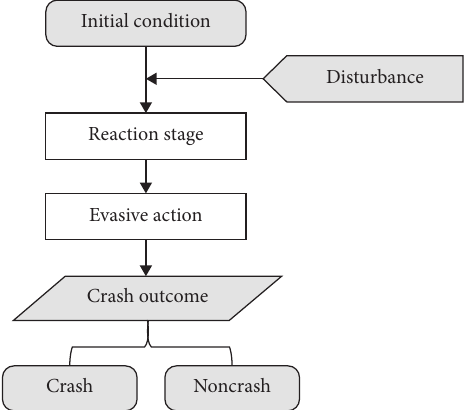
Figure 3: Schematic diagram of rear-end crash